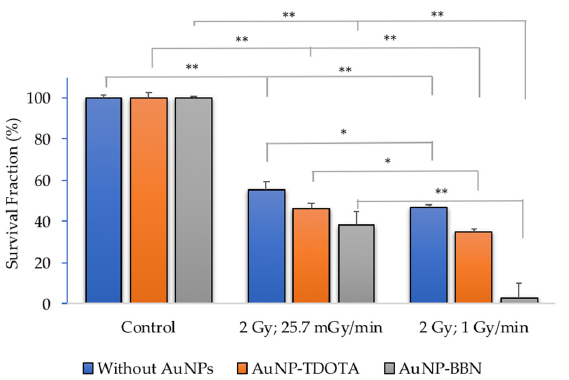
Figure 8. Quantification of the survival fractions in PC3 cells irradiated with 2 Gy, using two different dose rate values (25.7 mGy/min and 1 Gy/min) of Co-60, following incubation with AuNP-TDOTA and AuNP-BBN at a concentration of 36 µg Au/mL. Statistical significance was calculated using two-tailed Student’s t -test with irradiation-only cells as the control (* p ≤ 0.05) and between treatment groups (** p ≤ 0.001). The results were calculated from independent biological replicates ( n = 2) and are given as the mean ± S.E.M.